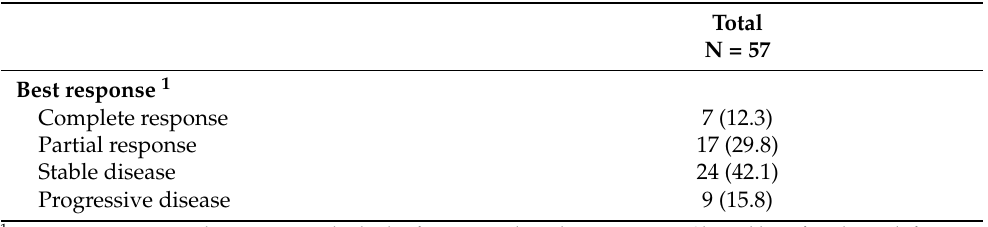
Table 2. Best response. All data are presented as frequencies (N (%)) unless specified.